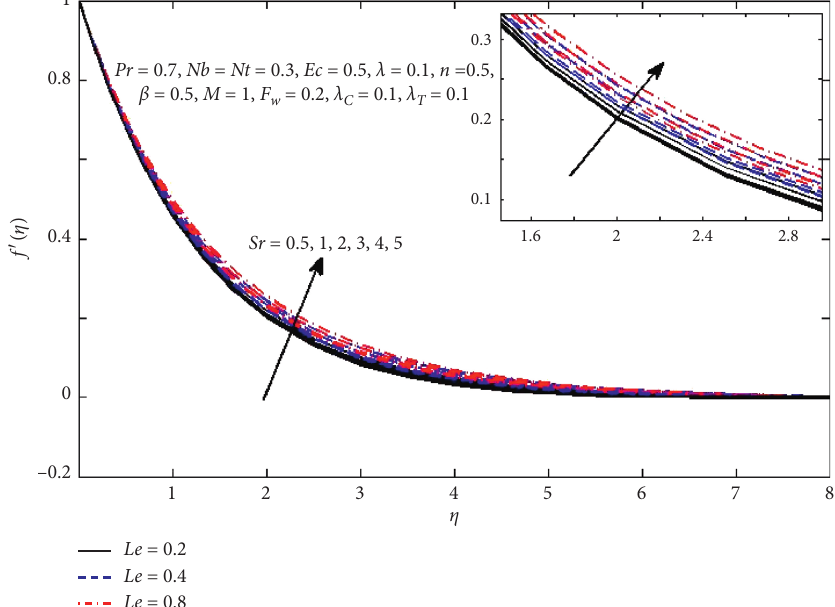
Figure 20: Variation of velocity f ′ concerning η with various values of Srand